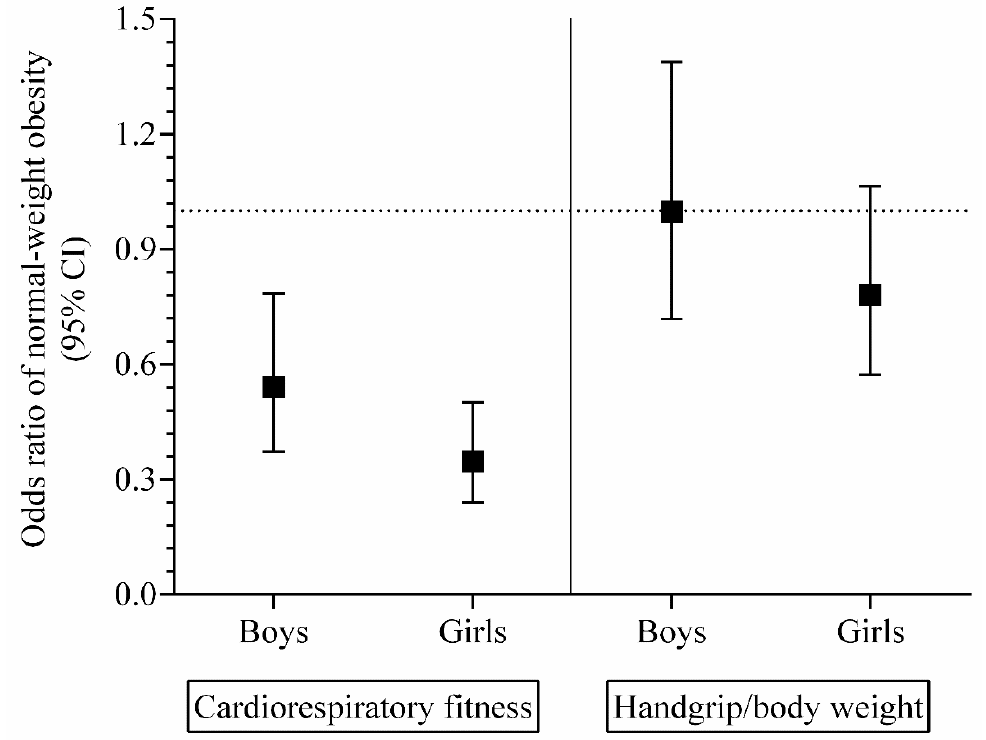
Figure 2. Odds ratios (ORs) to be classified as normal-weight obese according to fitness categories. Reference (OR = 1.0), unhealthy physical fitness level [15] (CRF < 47.9 mL·kg −1 ·min −1 in boys and < 34.4 mL·kg −1 ·min −1 in girls aged 9–12.9 years, and < 48.0 mL·kg −1 ·min −1 in boys and < 33.8 mL·kg −1 ·min −1 in girls aged 13–17.9 years, respectively) and unhealthy handgrip/body weight levels [16] (< 0.359 and < 0.376 in girls and boys aged 9–12.9 years, respectively. In adolescents (13–17.9 years), these points were < 0.440 and < 0.447 in girls and boys, respectively).